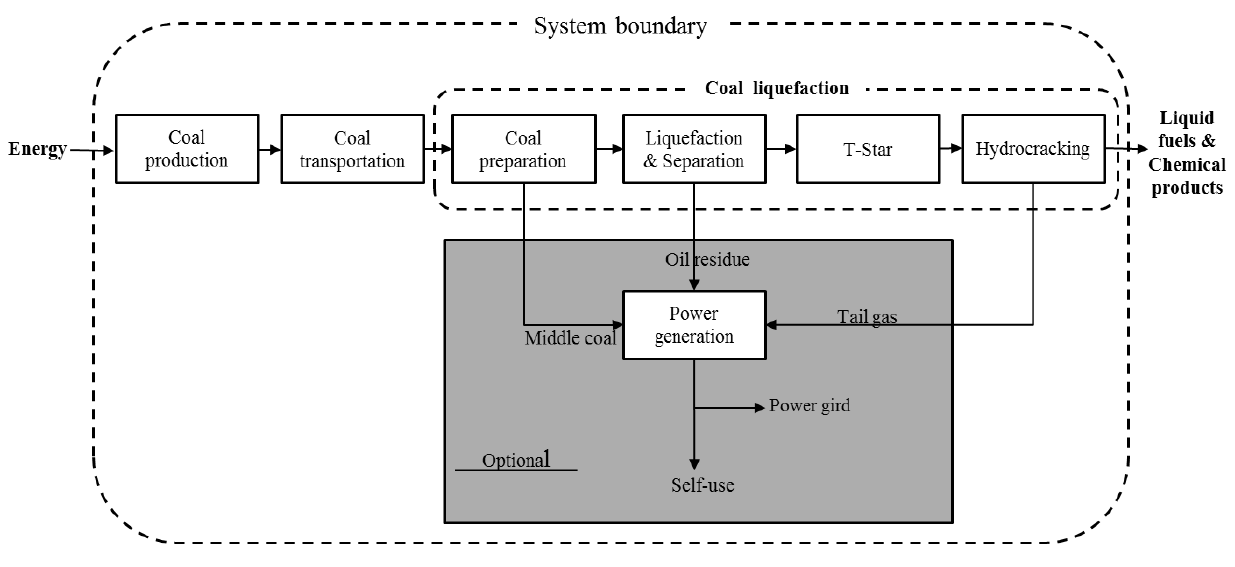
Figure 2. The system boundary of the Shenhua DCL production